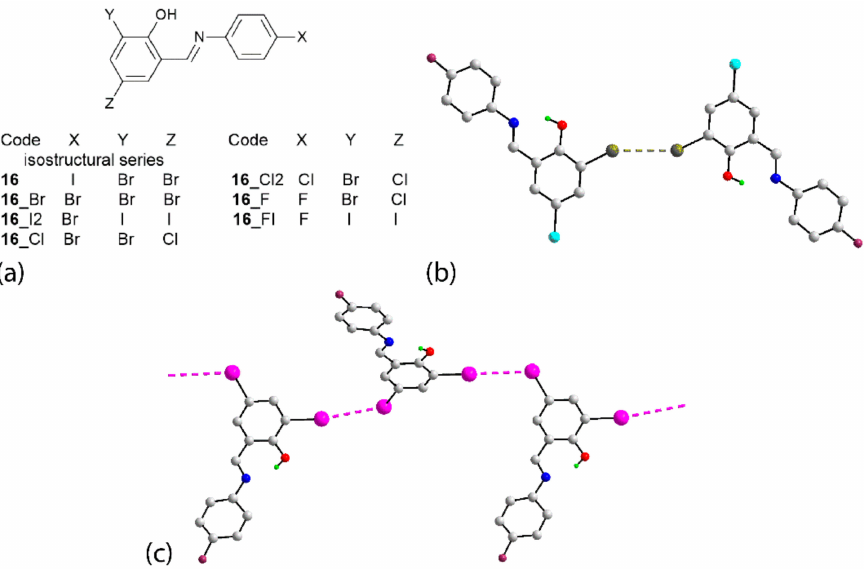
Figure 14. ( a ) Chemical diagrams for the congeners of 16 , ( b ) the centrosymmetric dimer in 16 _F (d(Br · · · Br) = 3.5526(9) Å; 2 × C–Br · · · Br = 140.32(10) ◦ ) and ( c ) a view of the zigzag, one-dimensional chain in the crystal of 16 _FI (d(I · · · I) = 3.7476(15) Å; C–I · · · I = 161.58(4) ◦ and C–I · · · I = 109.34(4) ◦